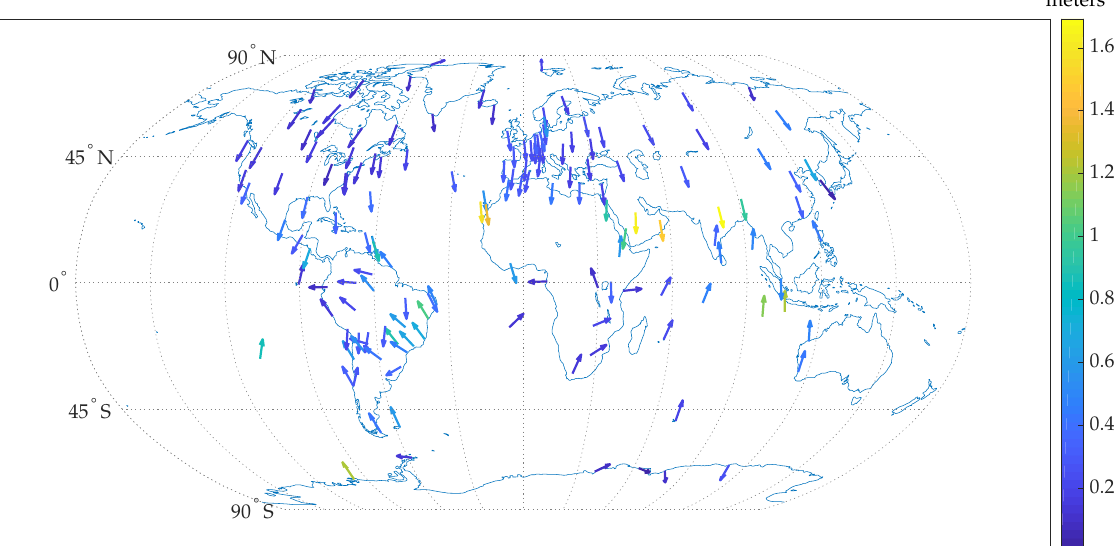
Figure 1. Direction and magnitude (the latter represented by color, in meters) of the long-term average horizontal position error due to errors in the delay estimates provided by the IGS GIM. Note that the meridians are curved outwards due to projection of the spherical map, and that arrows parallel to the curved meridians point directly south or